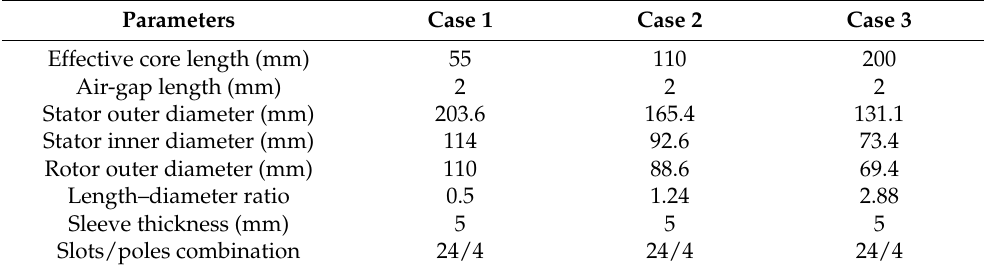
Table 8. Structural parameters of the rotor shape for HSPMM under three cases.